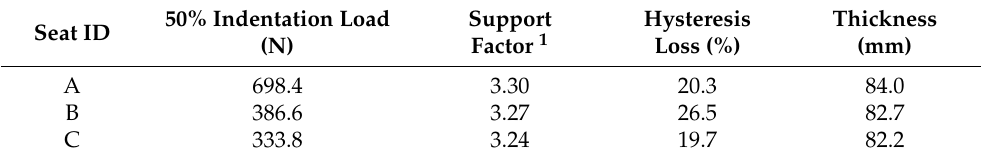
Table 1. Mechanical properties of the cushion foam pads.